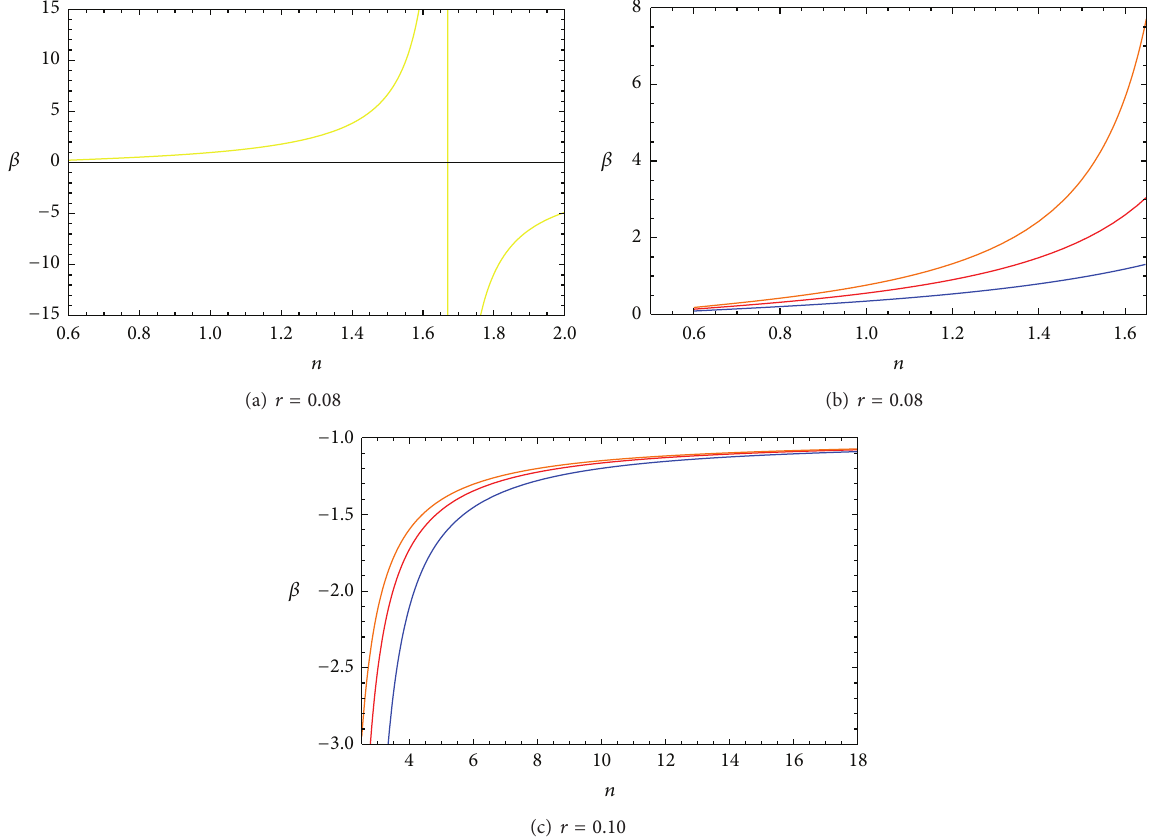
Figure 4: The Hubble power parameter 𝛽 is depicted versus 𝑛 for four different values of tensor-to-scalar ratio, as 𝑟 = 0 . 05 (blue line), 𝑟 = 0 . 08 (red line), 𝑟 = 0 . 11 (orange line), and 𝑟 = 0 . 14 (yellow line).